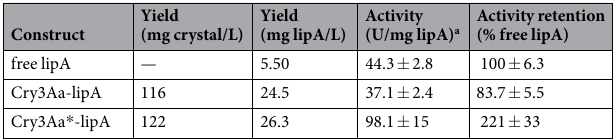
Table 1. Yield and specific activity of lipA constructs. a 1 unit is the amount of enzyme required to produce 1 μ mol pNP per min at 25 °C. Activity measurements were performed in triplicate, and the averages are shown with the standard deviation of the mean.